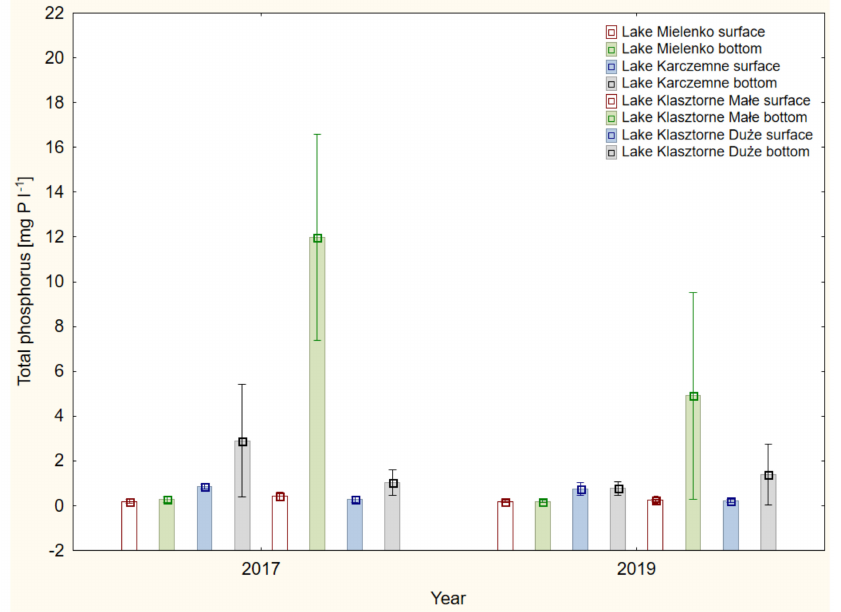
Figure 5. Mean annual values of total phosphorus (TP) in the water of Kartuzy lake complex in selected research years (box ± SEM, whisker plots ± Standard Deviation). Table 4. Variability of nutrients, chlorophyll a and Secchi disc visibility in study lakes. Mielenko Karczemne Klasztorne Małe Klasztorne